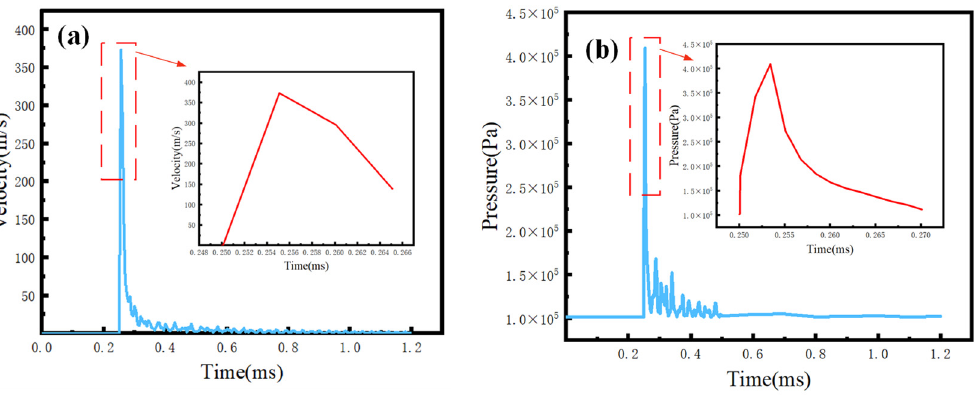
Figure 7. Variation in plasma expansion velocity and pressure with time: ( a ) he plasma expansion velocity varies with time; ( b ) plasma pressure varies with time.